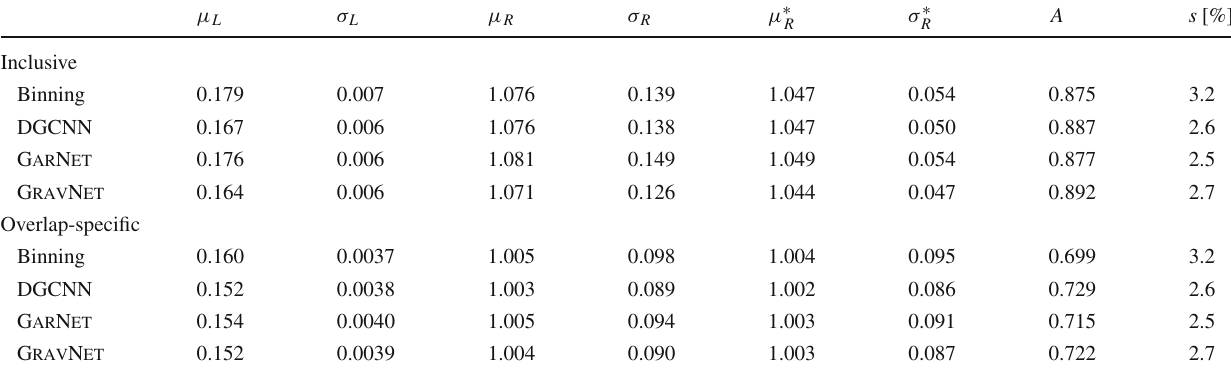
Table 3 Mean and variance of loss, response, and response withinthe Gaussian kernel as wellas clustering accuracycorrectedfor shower swapping. The last column shows the fraction of swapped